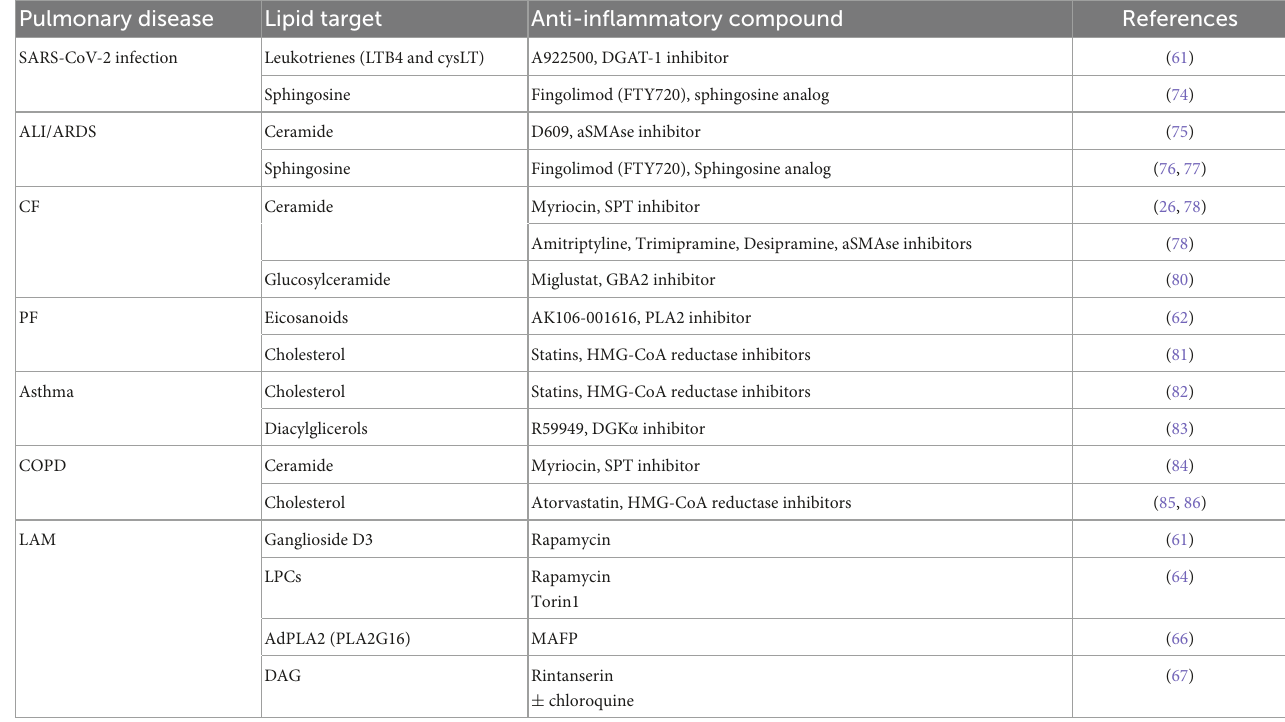
TABLE 1 Anti-inflammatory efficient compounds targeting lipid pathways in pulmonary diseases. Pulmonary disease Lipid